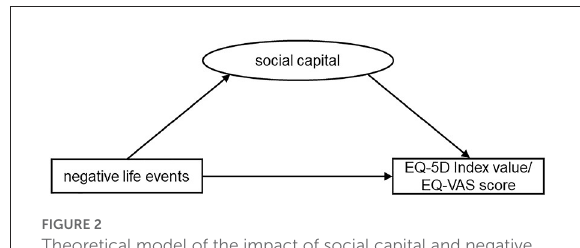
FIGURE2 Theoretical model of the impact of social capital and negative life events on QoL of adults.